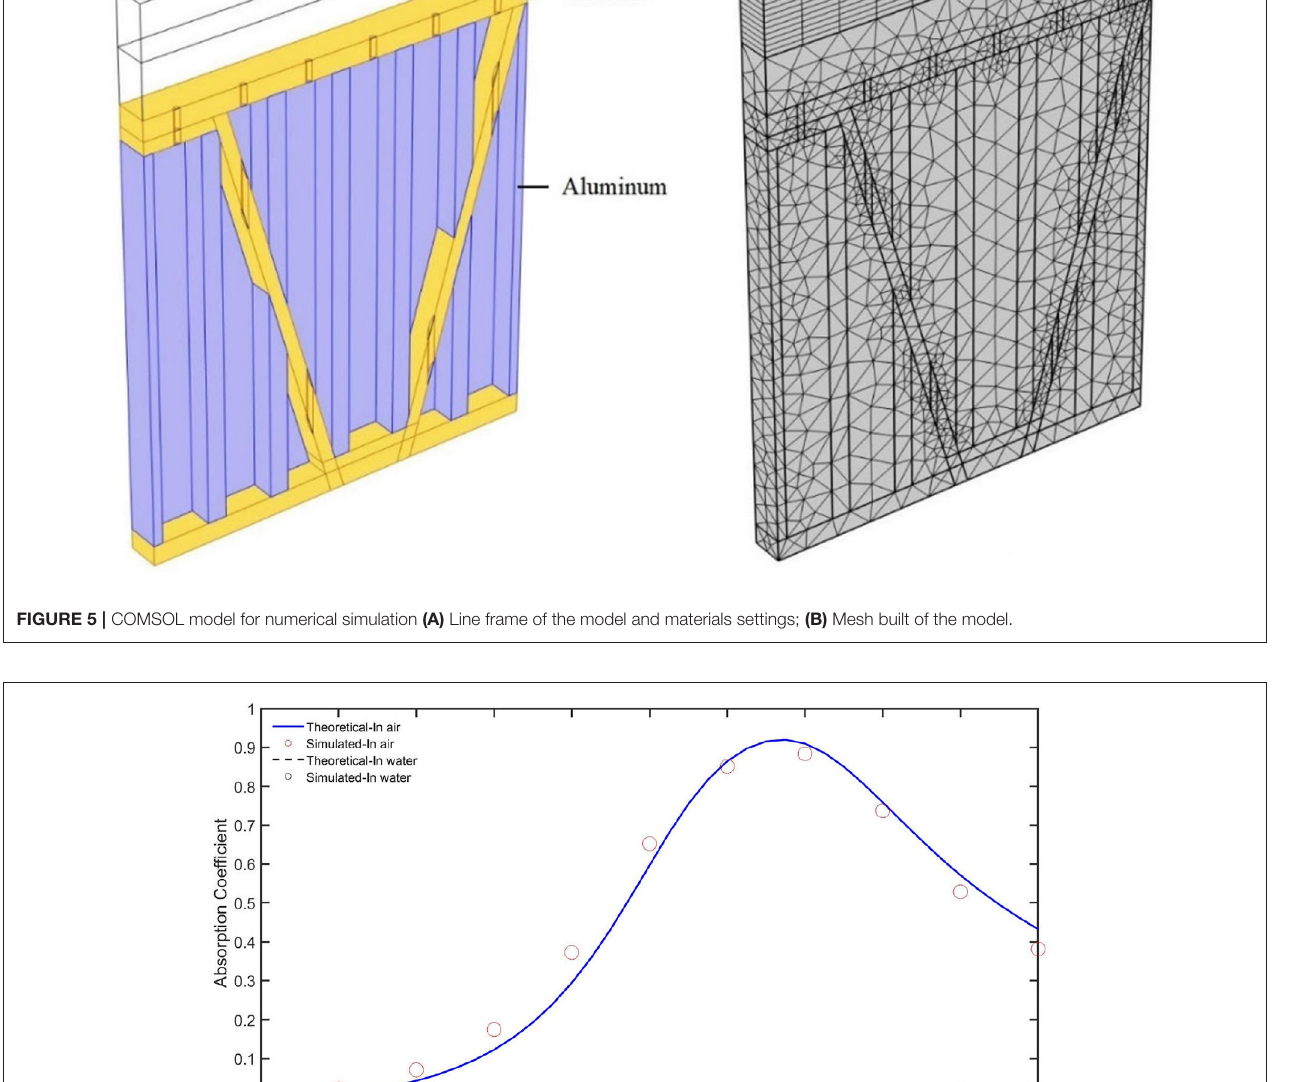
with water. On the top, there is a perfectly matched layer (PML) that absorbs all the acoustic waves reflected from the structure to simulate an infinite semi-space. Right beneath the PML is an incident field with background pressure. The boundary of the incident field is set under the periodic condition to simulate an infinite water area. A pressure acoustic module is applied in the